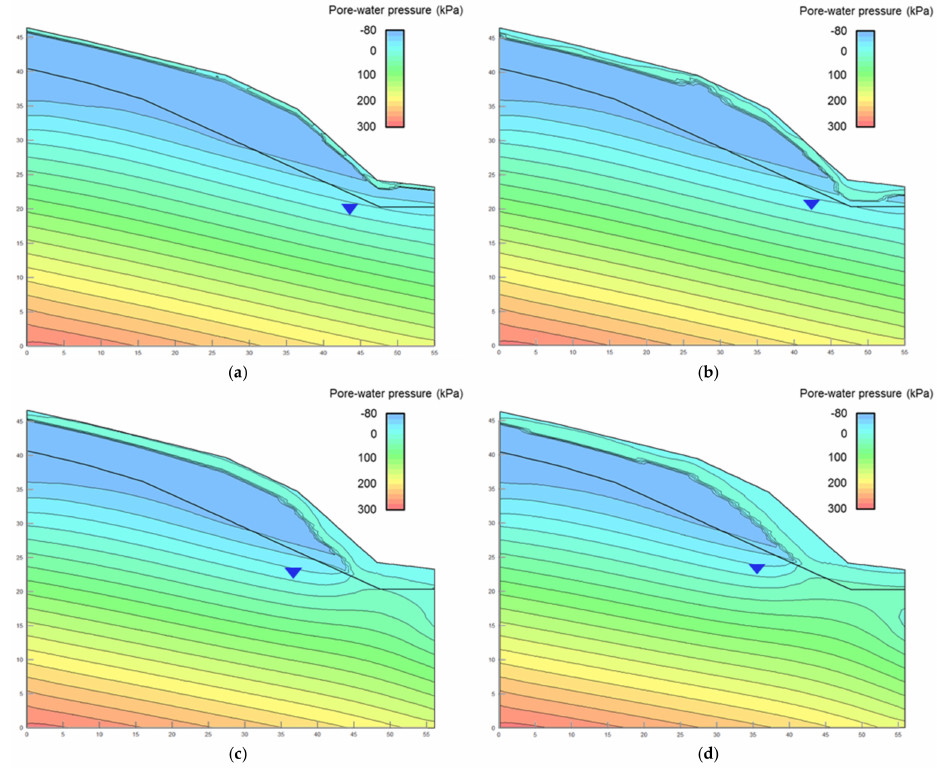
Figure 7. Pore-water pressure change with time in 2100 (Da-Dong-Shan rainfall station, 25 mm/h): ( a ) 6 h; ( b ) 12 h; ( c ) 18 h; ( d ) 24